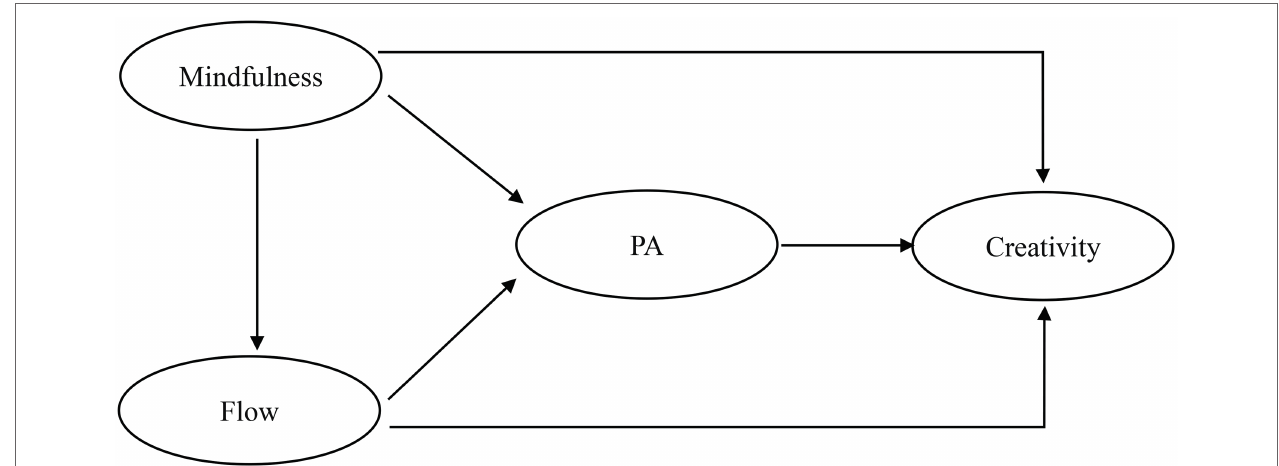
FIGURE 1 | Research model.